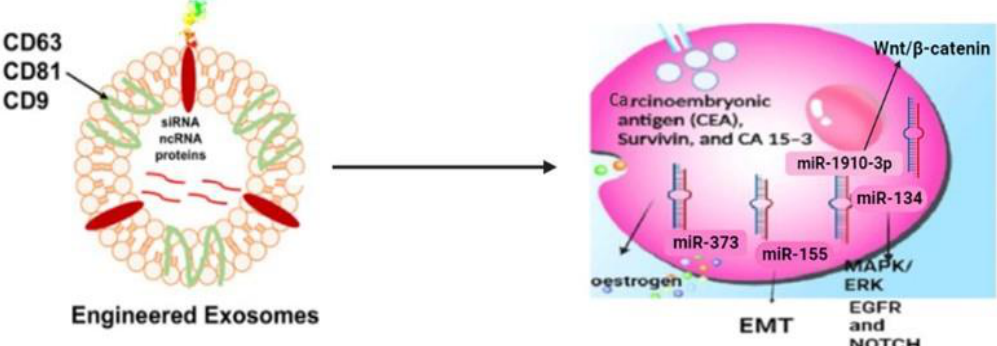
Figure 1. Exosomes as a biomarker for TNBC—showing different protein contents inside exosomes, which are used for identifying TNBC and also in ‘liquid biopsy’. Carcinoembryonic antigen (CEA), survivin, CA 15-3(Cancer antigen 15-3), miR-373, mi-134, miR-1910-3p, and miR-155 are some of the biomarkers (https://biorender.com/, accessed on 30 October 2022).